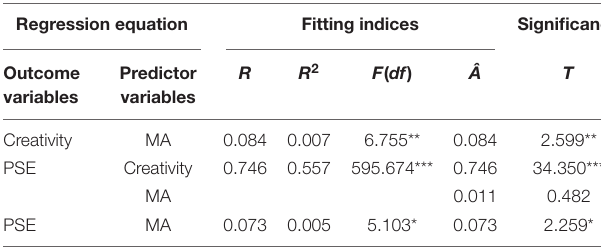
TABLE 3 | Mediation analysis results for the observed variables.